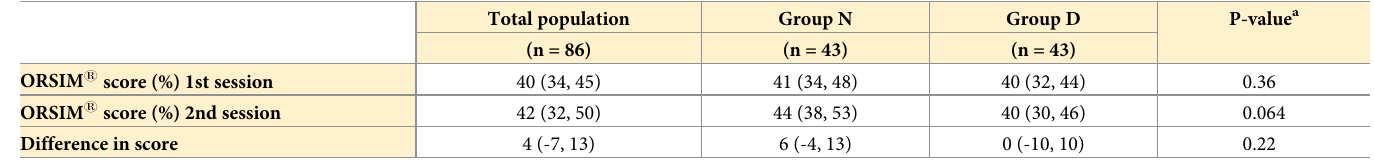
Table 2. Pre-test dexterity.